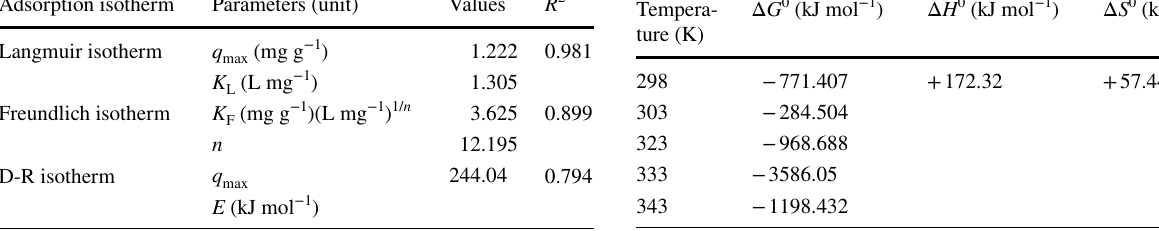
Table 1 Isotherm data for adsorption of Cr(VI) by GO Adsorption isotherm